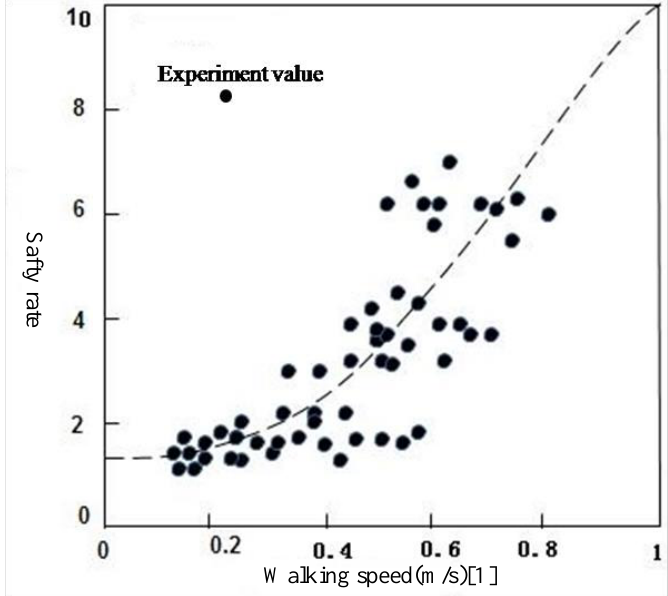
Figure 6. The relationship between safety rate and walking speed in evacuation